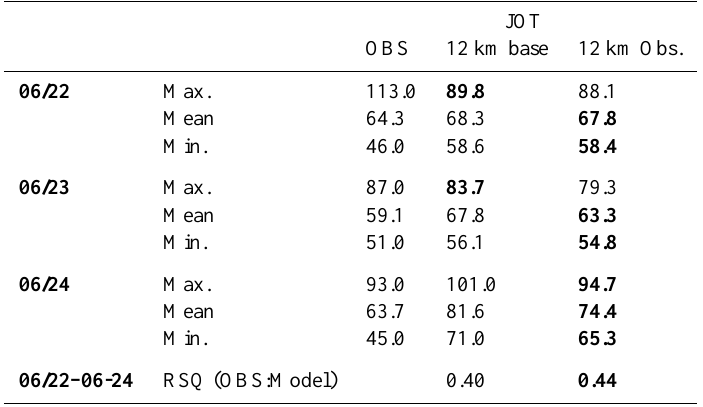
Table 3b. Comparisons between observed and modeled O 3 at the southern California site JOT, better model simulations are in bold (OBS-